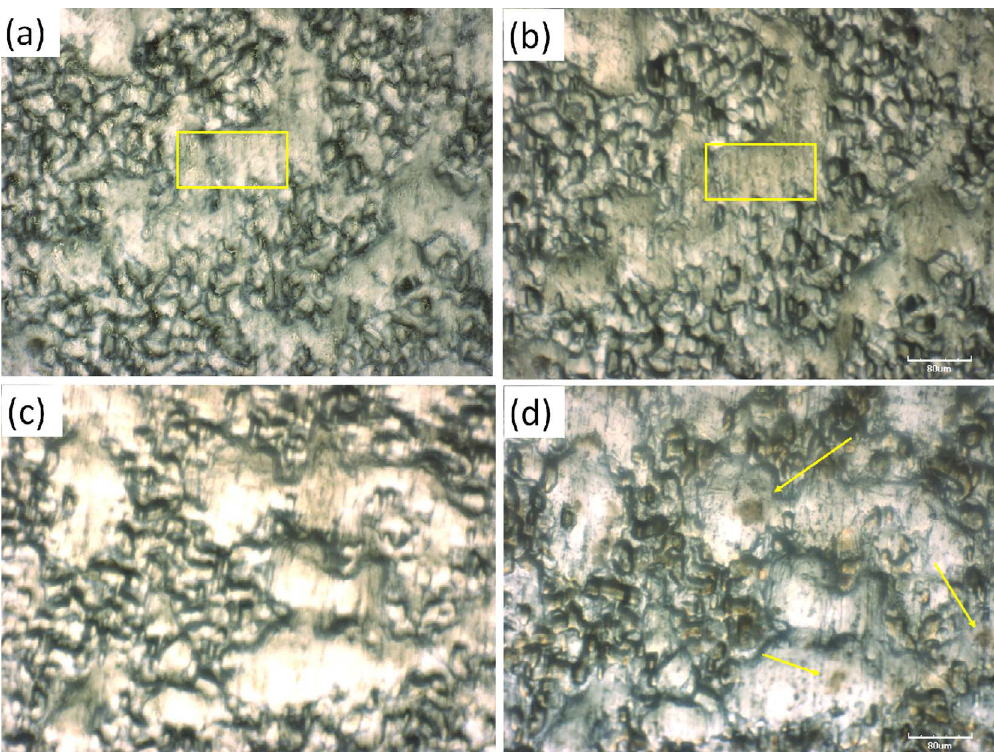
Figure 6. Photomicrographs with LSCM of the steel samples in the conversion bath (hexafluorozirconic acid solution) at pH 3.0 in a) 30 s, b) 1 h, and pH 5.0 in c) 30 s, d) 1 h, magnification of 80